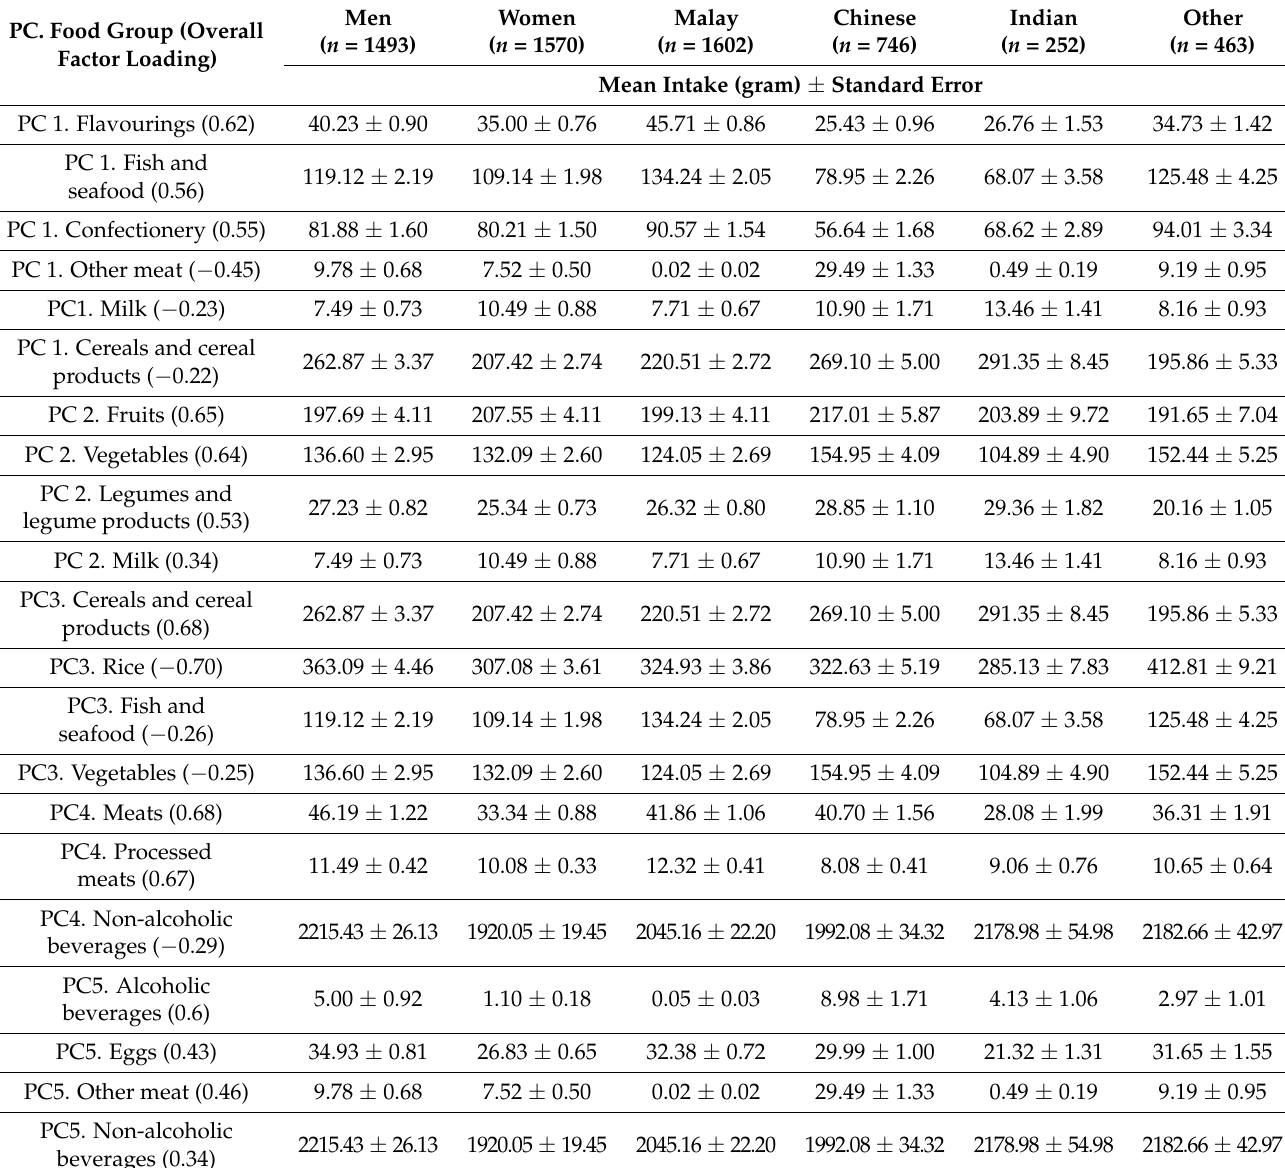
Table 6. Mean grams food consumed by food groups of derived dietary pattern and the analysed population groups. PC. Food Group (Overall Factor